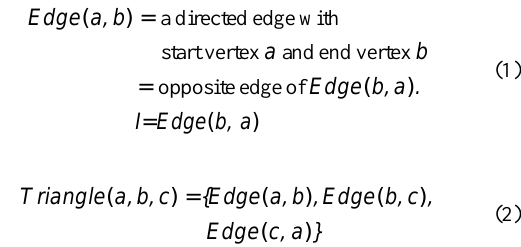
IndoorGML using only the geometric representation. Figure 6 shows an example of an IndoorGML document.